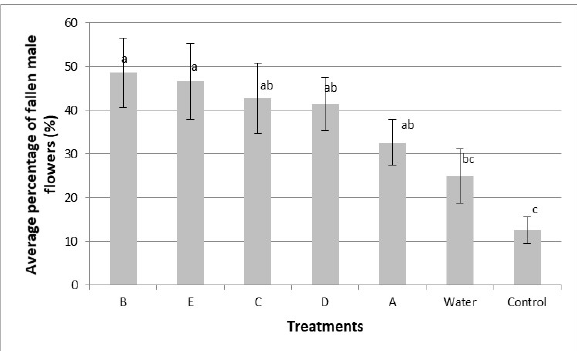
Figure 3. Average percentage of fallen flowers in male plants, standard error and Tukey test for the different treatments. Virú. La Libertad. Perú, May-June. 2008.